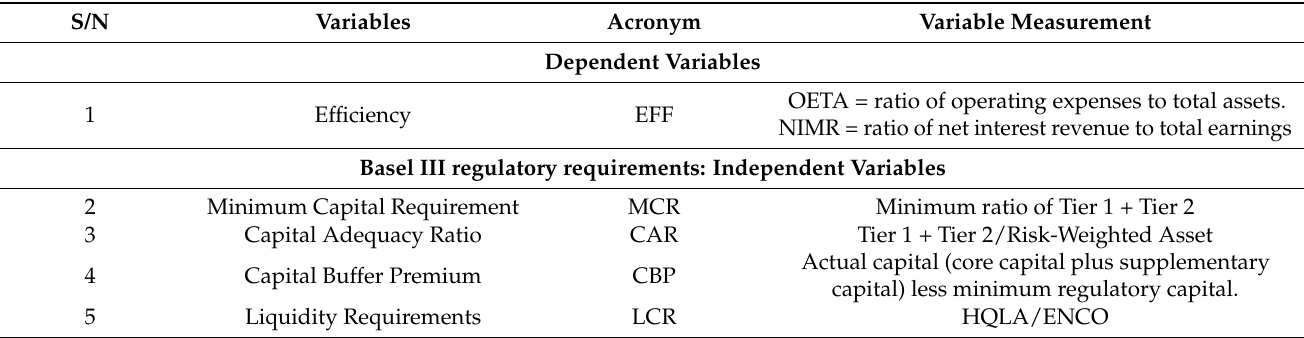
Table 1. Definition of the dependent and independent